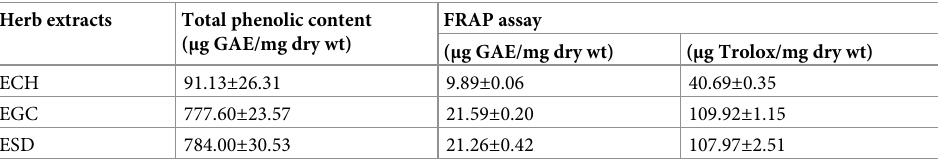
Table 1. Total phenolic content and its antioxidant accessed by FRAP method. Herb